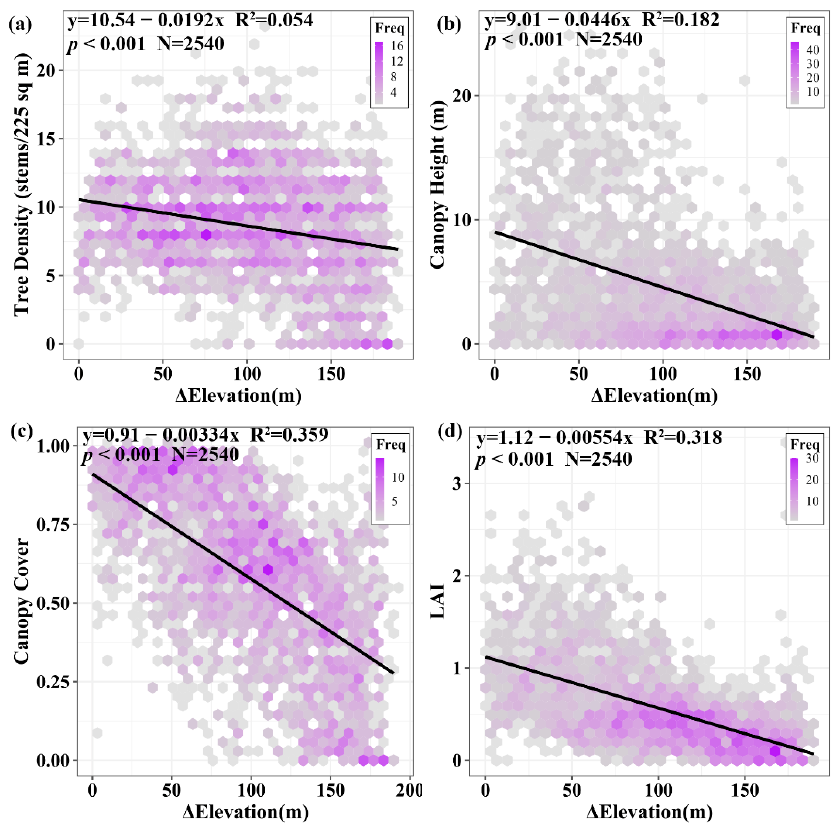
Figure 9. Relationships between forest indexes and the relative elevation. ( a ) linear regression and scatter plot of ∆ Elevation and tree density; ( b ) linear regression and scatter plot of ∆ Elevation and canopy height; ( c ) linear regression and scatter plot of ∆ Elevation and canopy cover; ( d ) linear regression and scatter plot of ∆ Elevation and leave area index; The number of points in the plot hexagon is denoted by colors (as per each embedded scale bar). Freq is the abbreviation of